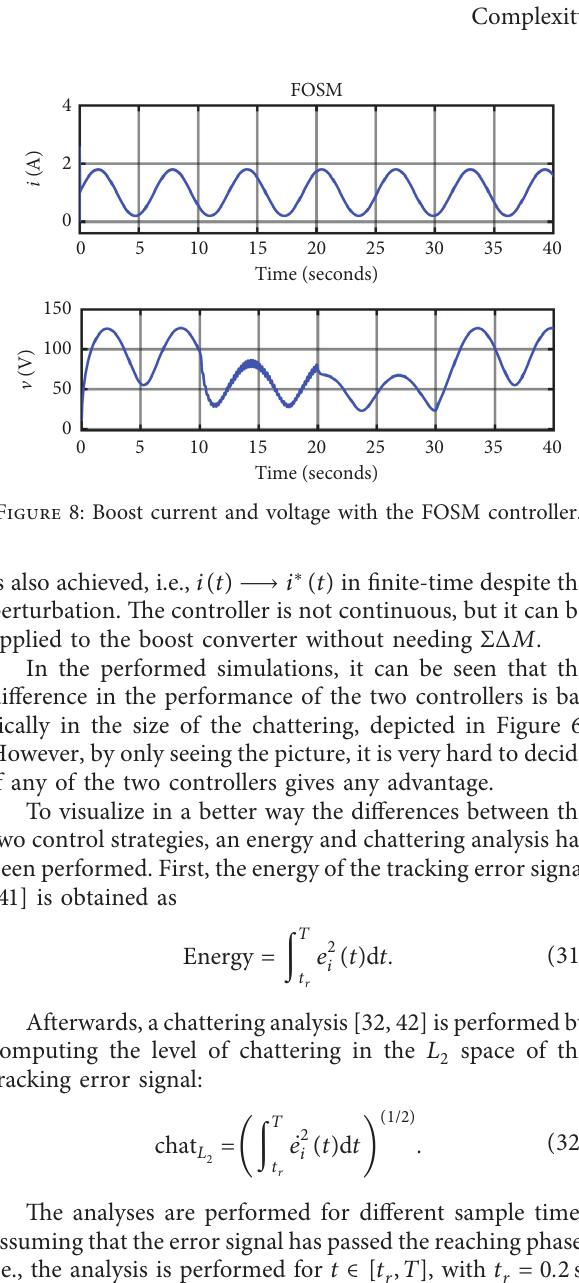
Figure 7: SSTA control signal.